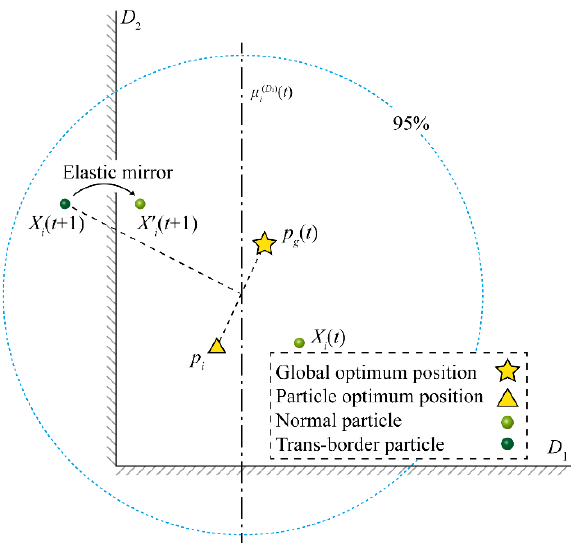
Figure 4. Schematic of the elastic mirror mechanism for handling trans-border particles.